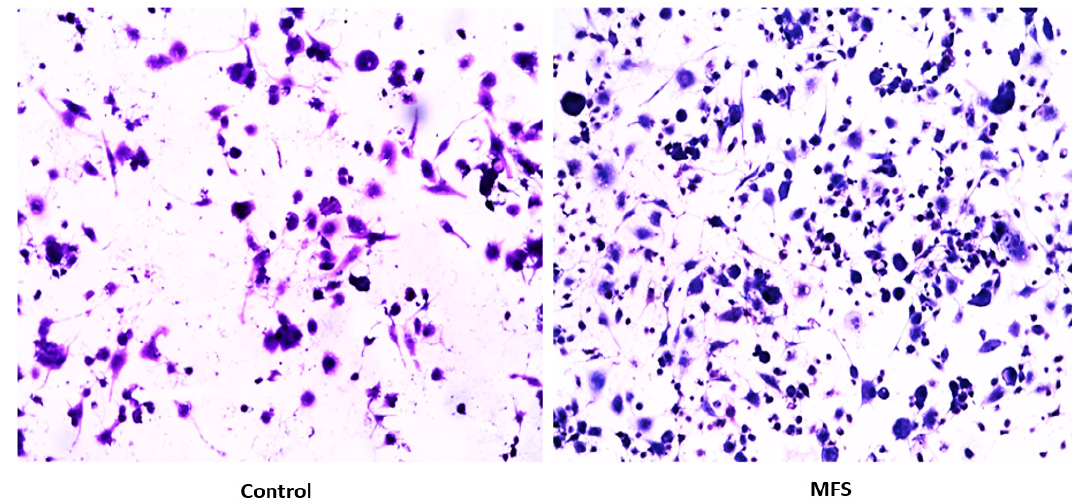
Figure 2. Hematoxylin and Eosin staining of untreated and MFS-treated samples of THP-1 cells. Microscopy work was done under 100 ×